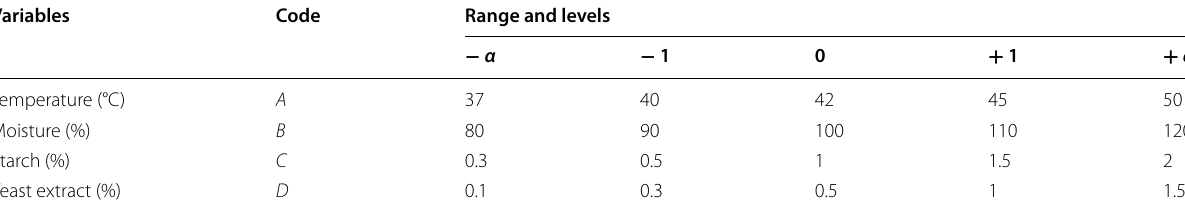
Table 4 Independent variables with their ranges and levels for CCD of RSM